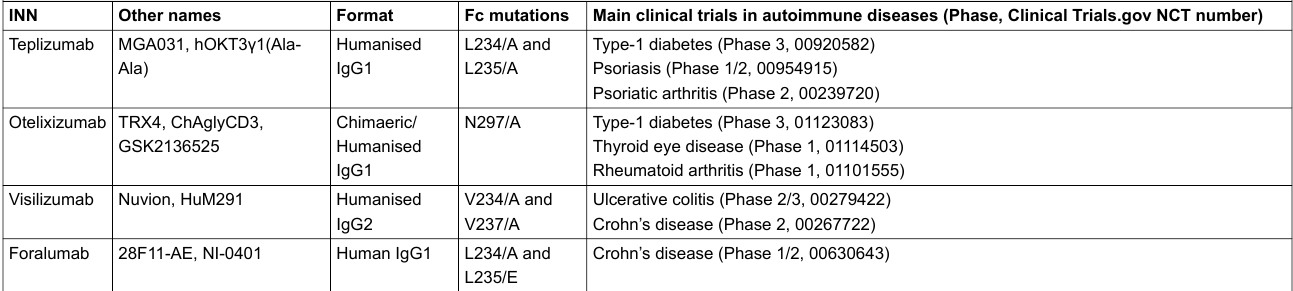
Table 1: CD3-specific antibodies in clinical development for the treatment of autoimmune diseases. INN Fc mutations Main clinical trials in autoimmune diseases (Phase, Clinical Trials.gov NCT number) Teplizumab MGA031, hOKT3γ1(Ala-